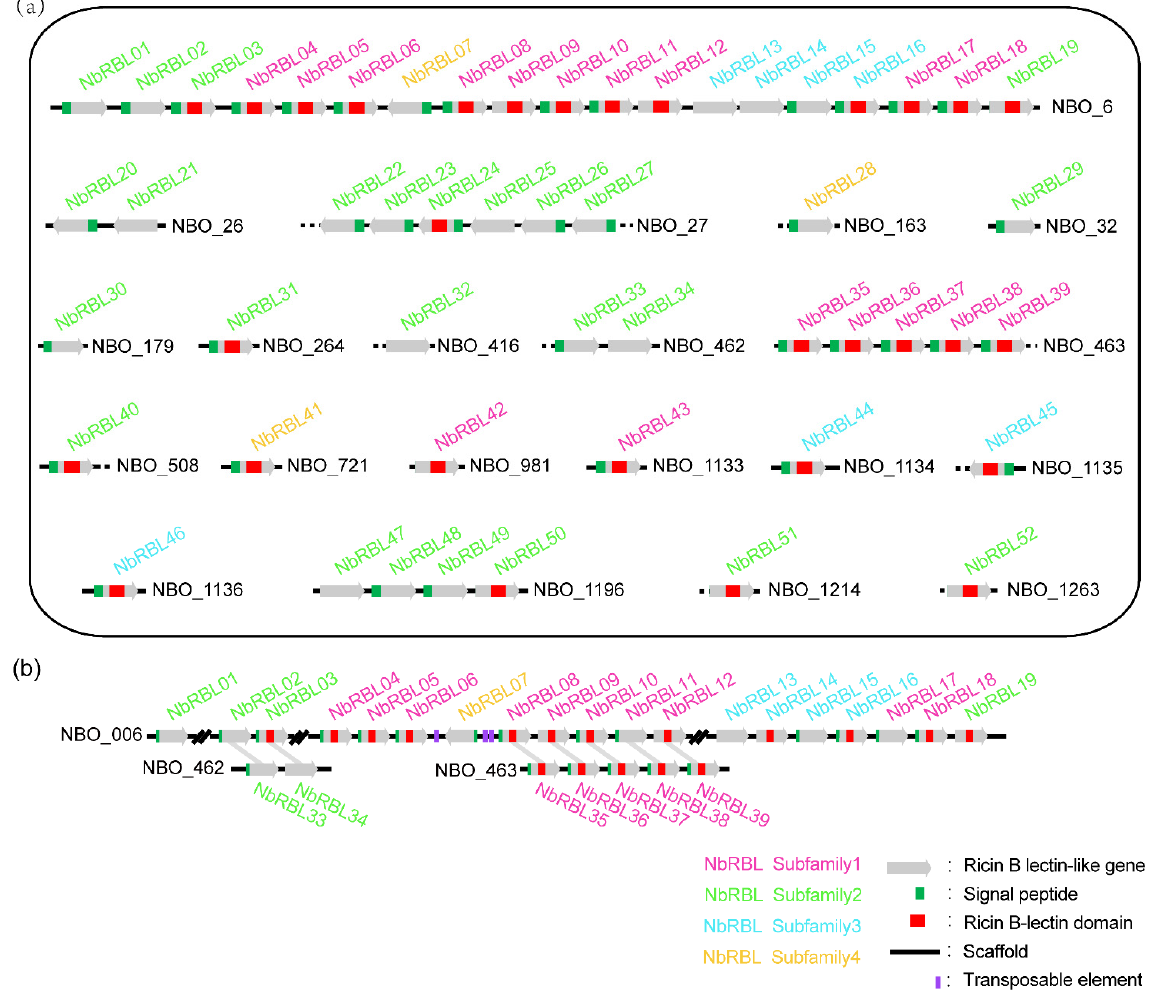
Figure 2. Chromosomal distribution of Nbrbls . ( a ) The 52 Nbrbls were localized to specific scaffolds based on the whole-genome sequences of the N. bombycis CQ1. A different color represents a different NbRBL subfamily. On the NBO_6 Scaffold, each NbRBL subfamily members were distributed. ( b ) Syntenic distributions of Nbrbls between scaffolds NB0_6, NB0_462, and NB0_463.